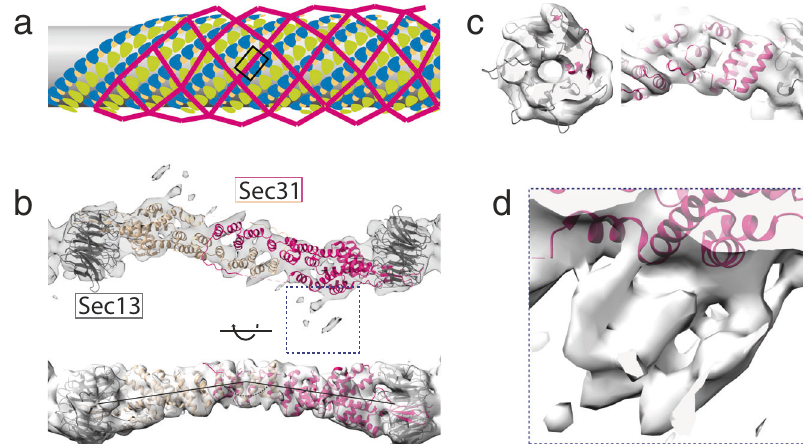
Fig. 2 Architecture of COPII rods organised in a left-handed manner. a Schematic representation of the outer coat lozenge architecture, with left-handed rod positions highlighted in the box. b Top panel: top view of the 11 Å subtomogram average of the COPII left-handed rod, with rigid-body fi tted models (PDB 2PM6). The dimerising protomers are shown in dark and light pink, Sec13 in grey. Bottom panel: side view of ( b ). c Details of the map in ( b ), showing the quality of the fi t. Left panel: detail of Sec13 β -propeller. Right panel: detail of Sec31 α -solenoid domain. Sigma threshold for contouring was set at 5 for ( b , c ). d Enlargement of the region boxed in panel ‘ b ’ shown at lower contour (sigma = 2.1) to display an extra